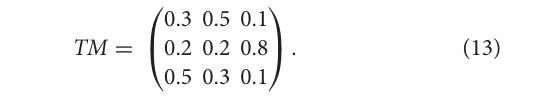
transition according to a transition matrix, TM , Here, the element TM ij represents the transition probability from state j to state i . The cross-spectra for the three states is presented in Figure 2C